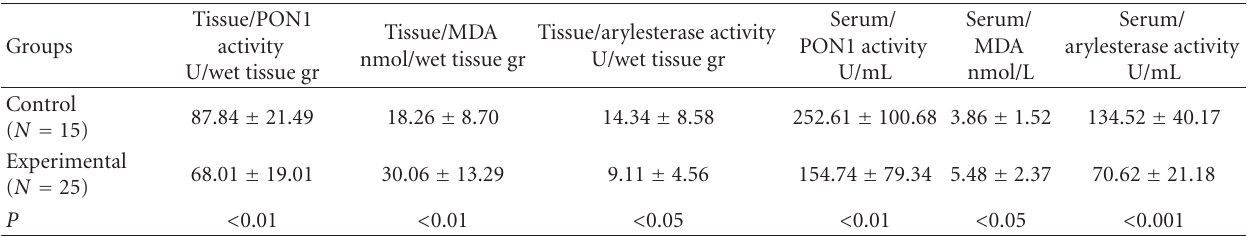
Table 1: PON1 and arylesterase activities and lipid peroxidation marker level in control and experimental (ischemic colitis) groups.